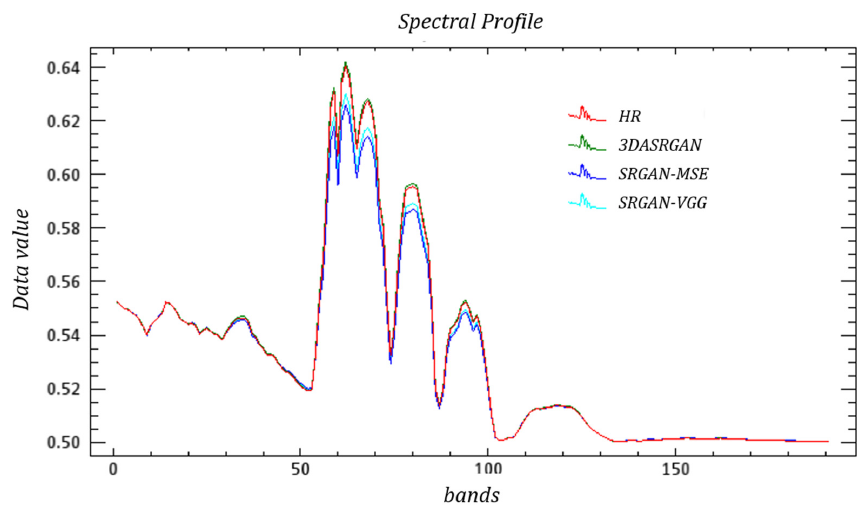
Figure 17. Example Spectral Curves of Grass based on the Washington DC Mall dataset.